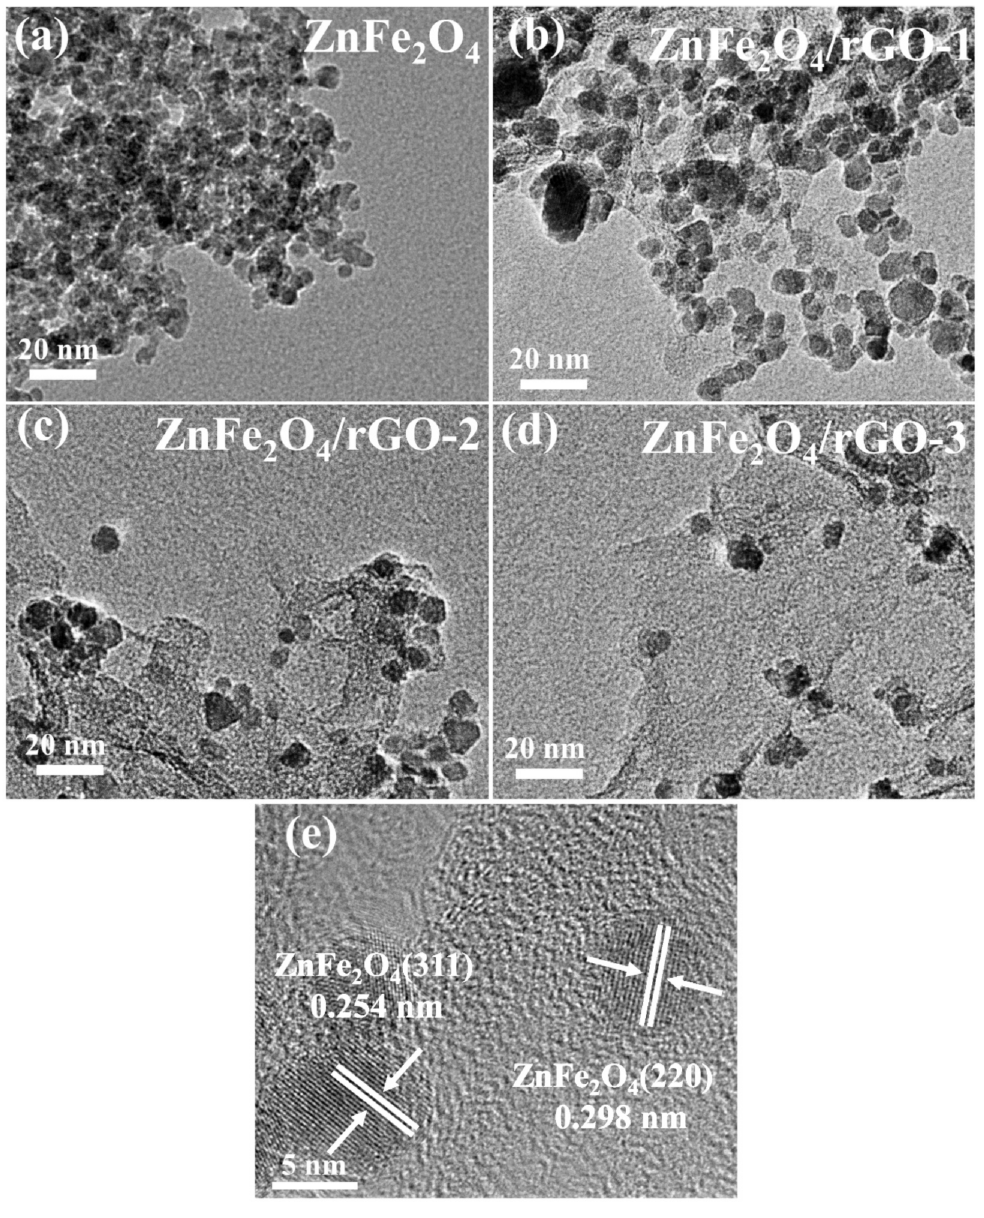
Figure 5. TEM images of ( a ) pure ZnFe 2 O 4 , ( b ) ZnFe 2 O 4 /rGO − 1, ( c ) ZnFe 2 O 4 /rGO − 2, and ( d ) ZnFe 2 O 4 /rGO − 3. ( e ) HRTEM of ZnFe 2 O 4 /rGO −